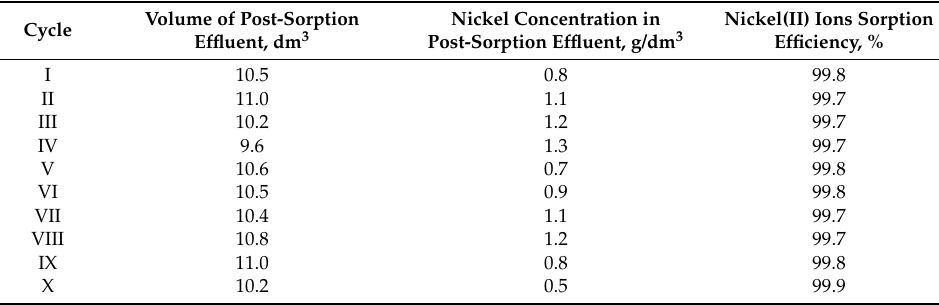
Table 1. Nickel(II) ions sorption results—10 cycles before the regeneration.